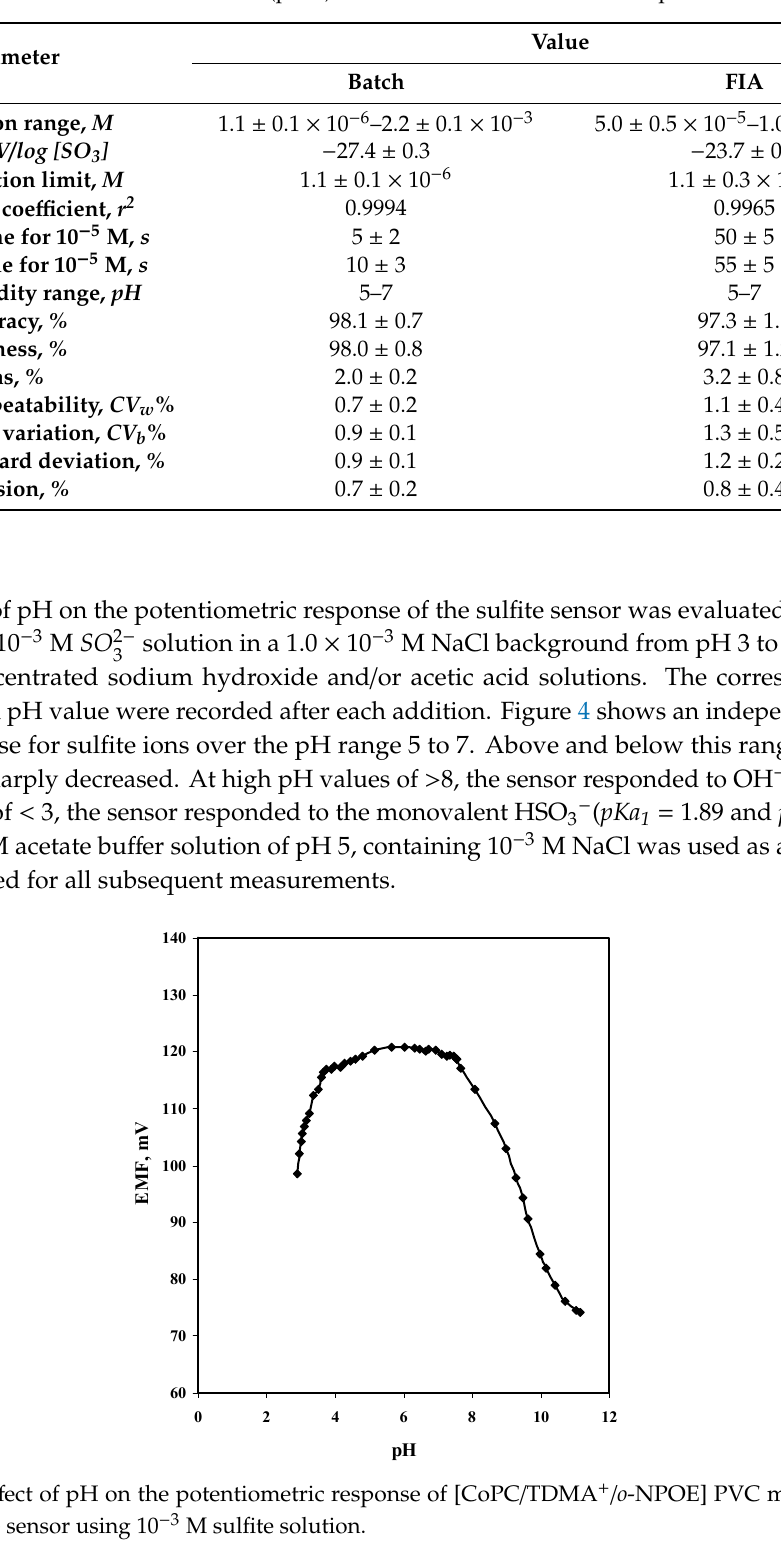
Table 1. Performance characteristics of the [CoPC/TDMA + /o-NPOE] sulfite PVC membrane sensor in